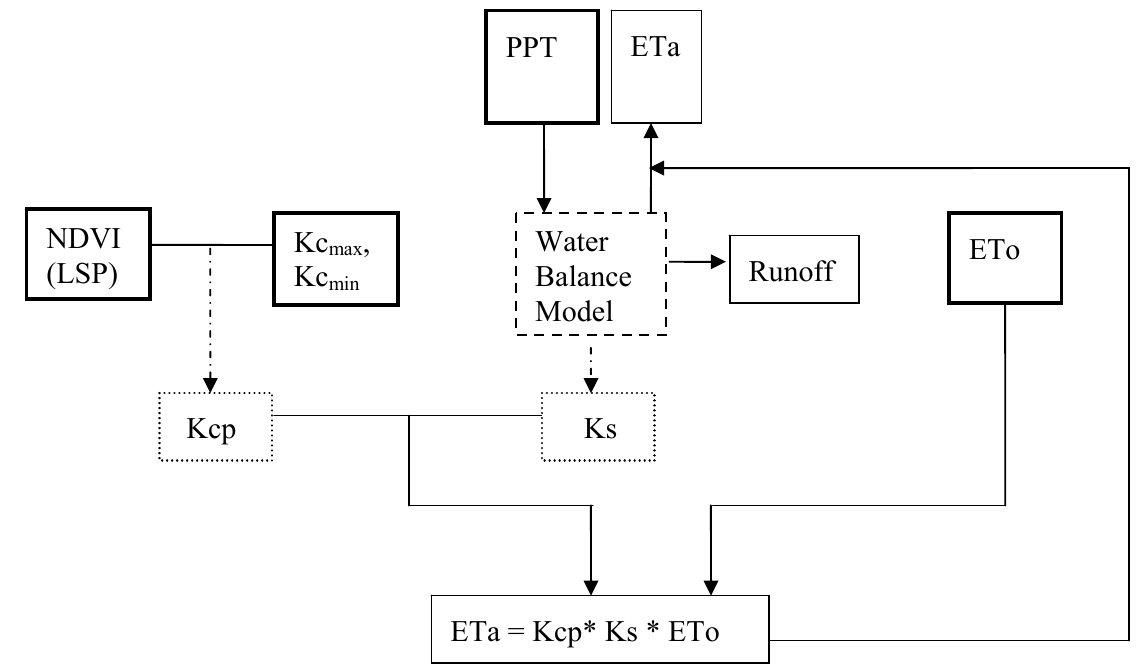
Figure 1. A simplified conceptual diagram of the VegET model. Major inputs are: precipitation (PPT), reference ET (ETo) and NDVI/Kc. Estimated parameters are phenology-based crop coefficient (Kcp) and soil-water stress factor (Ks). Model outputs are ETa and